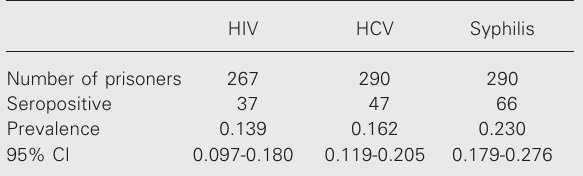
Table 1. Seroprevalence of HIV, HCV and syphilis among female prisoners at the Butantã Women’s Penitentiary, São Paulo, Brazil, in